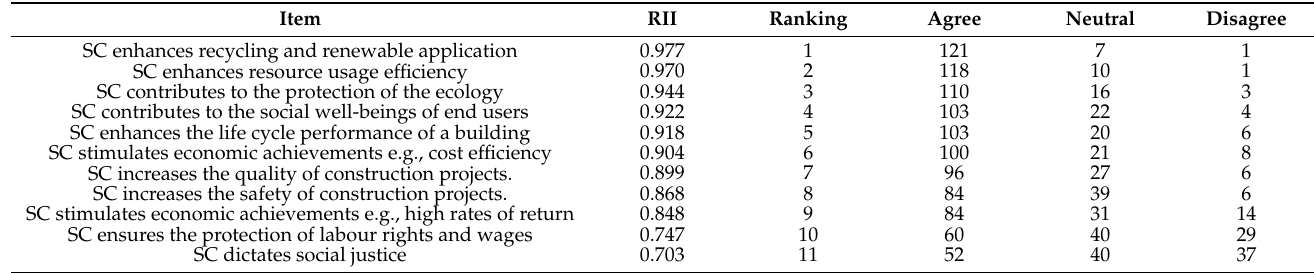
Table 16. RII ranking of the merits associated with